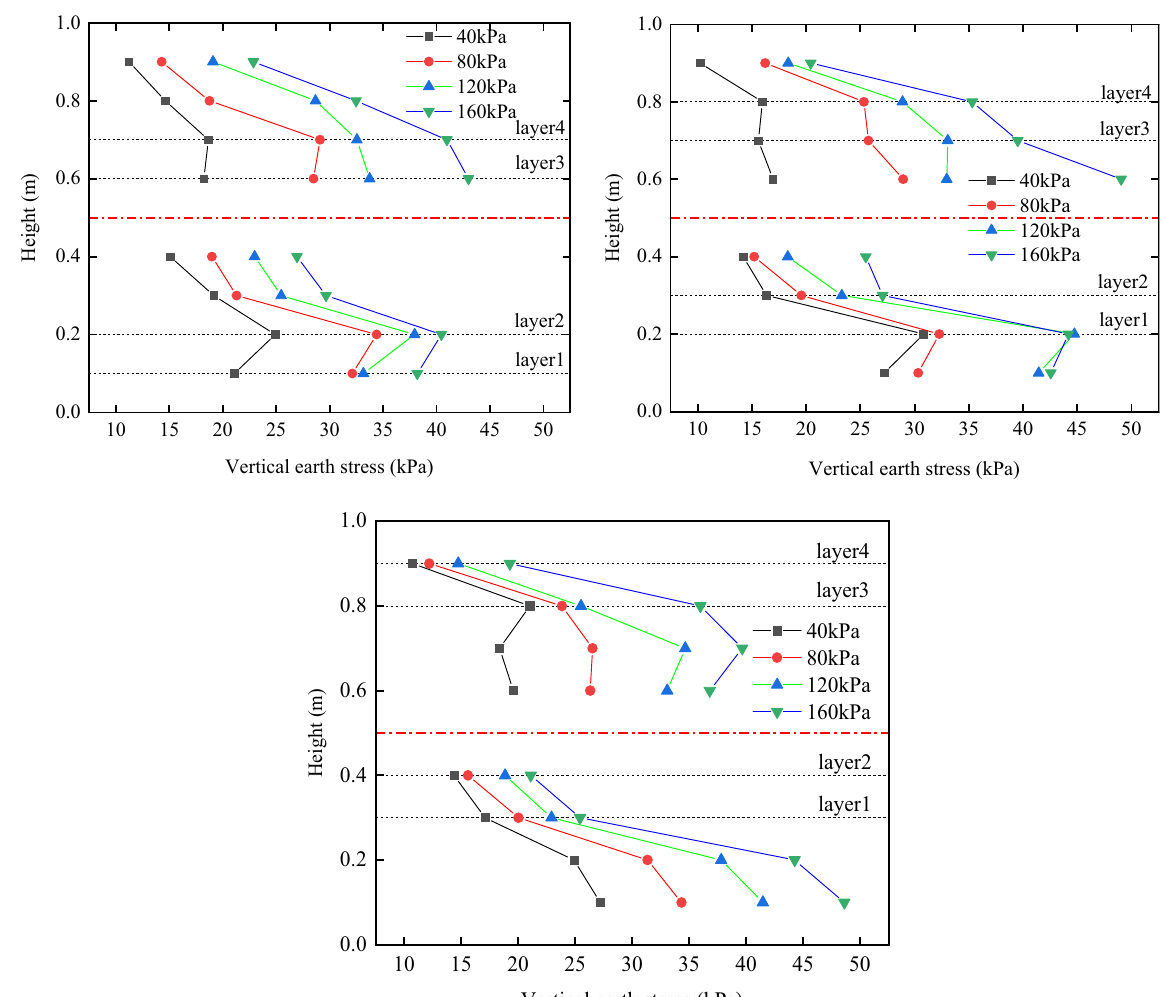
Figure 9: Vertical earth pressure on wall back under three working conditions, D2 ( upper - left ) , M2 ( upper - right ) , and U2 ( bottom )